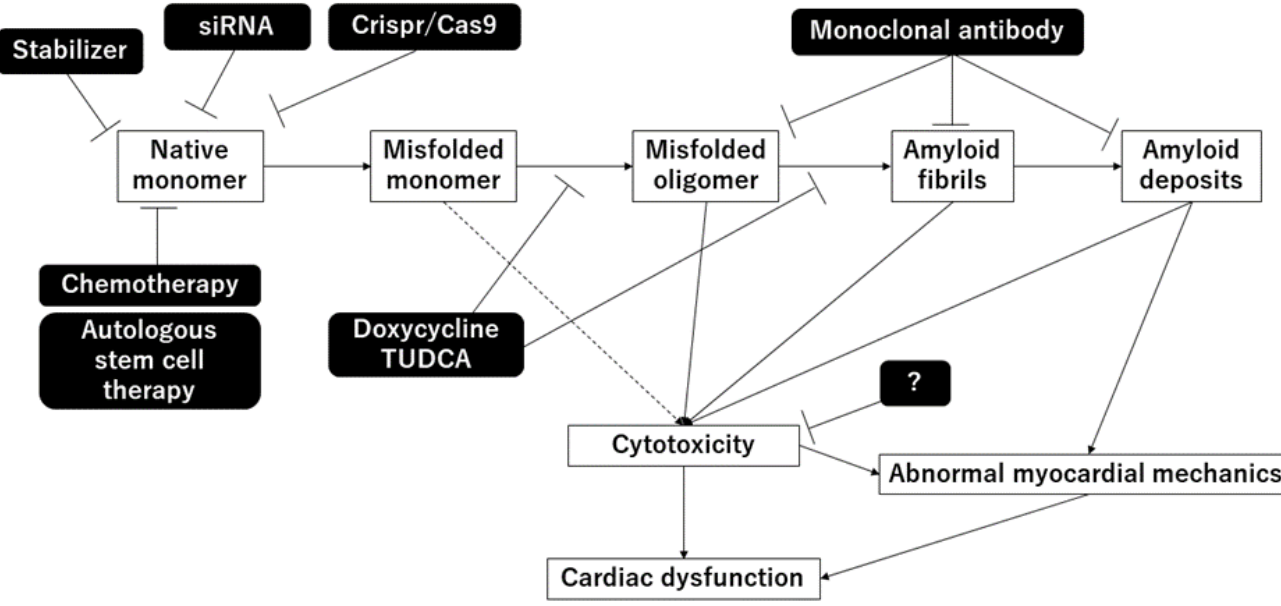
Figure 1. Mechanisms of amyloidosis and treatments.